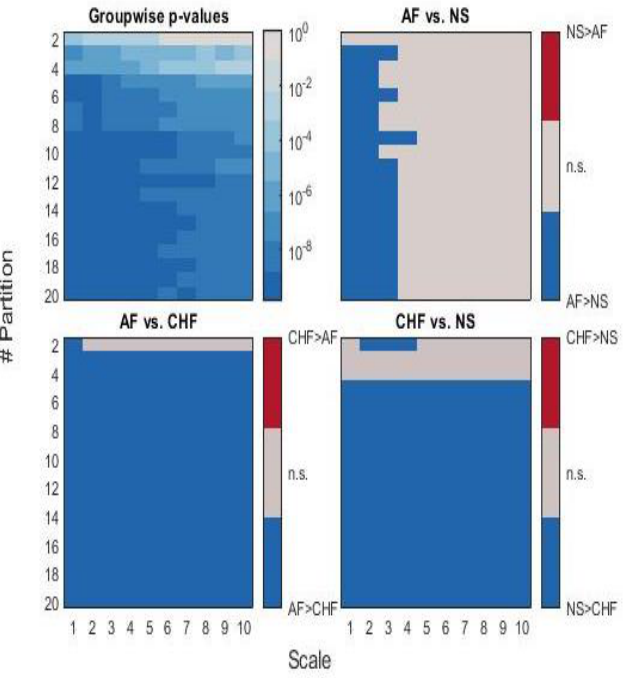
Figure 6. Graphical representation of the statistical analysis results. Top-left corner: p -values from a nonparametric Kruskal–Wallis test (i.e., AF vs. CHF vs. NS) for each scale and partition. The other images represent results of pairwise comparisons through non-parametric Mann–Whitney test for unpaired samples: light grey areas represent non-significant differences in terms of MKSE with p -value > α 1 = 0.00167, whereas blue areas denote p -value < α 1